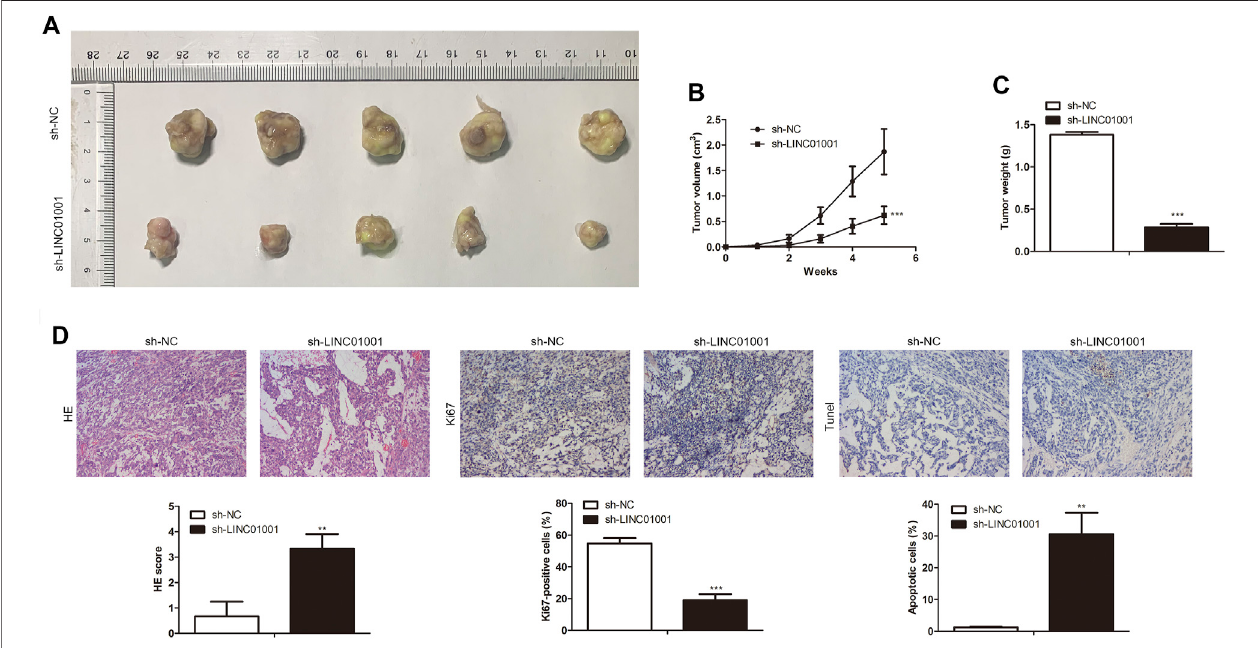
FIGURE 3 | Inhibition of LINC01001 depresses crizotinib-resistance of NSCLC in vivo . (A) Tumor size. (B) Statistical analysis of tumor volume (3 days). (C) Statistical analysis of tumor weight (15 days). (D) H&E staining and IHC staining assessed the level of Ki67 in tumor tissues (15 days). ** p < 0.01, *** p < 0.001 vs sh-NC group. Error bars represent SD. Data represent three independent